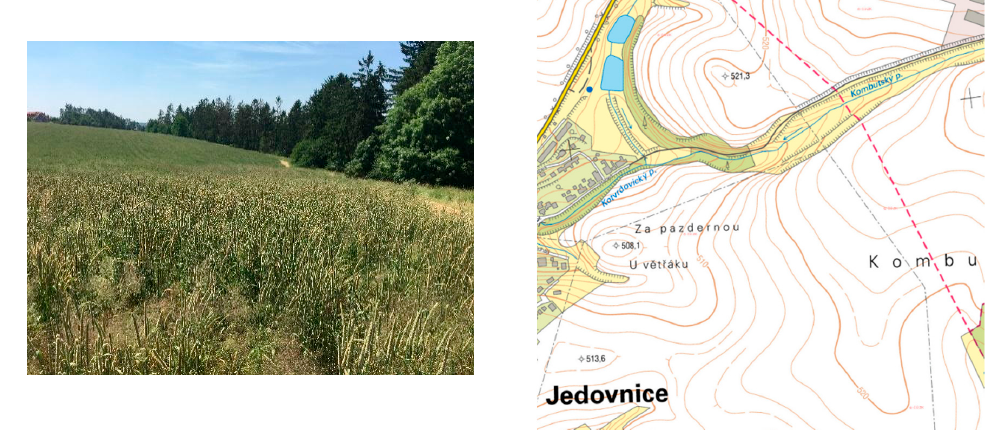
Figure 9. Landscape in Jedovnice area and a topographical situation [22].